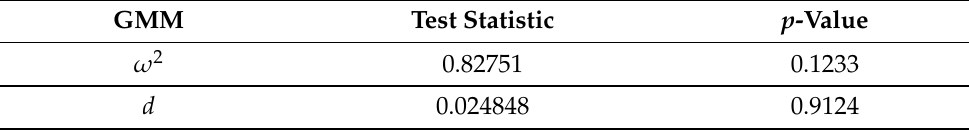
Table 3. KS and CVM testing using a pseudo-CDF for the